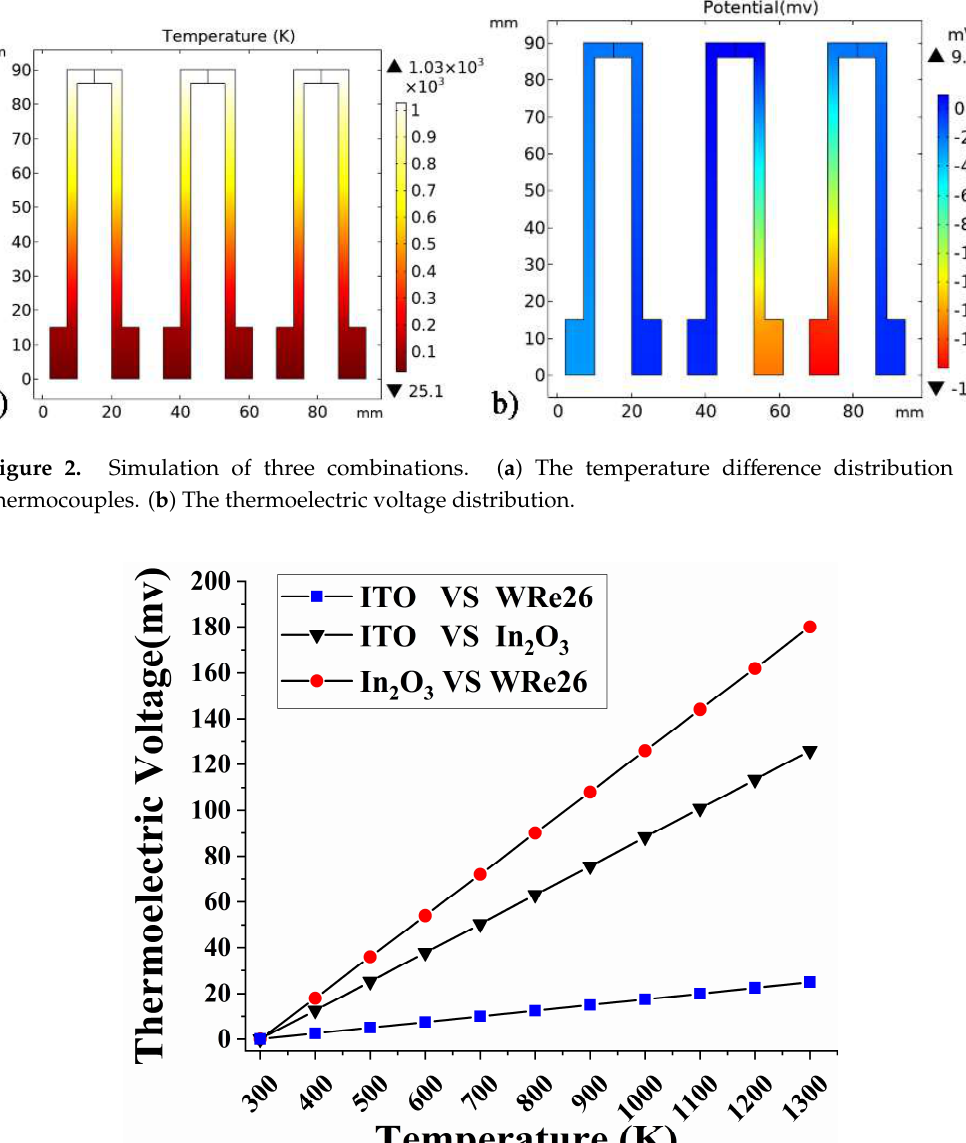
Figure 3. Thermoelectric voltage of three combinations simulation results.